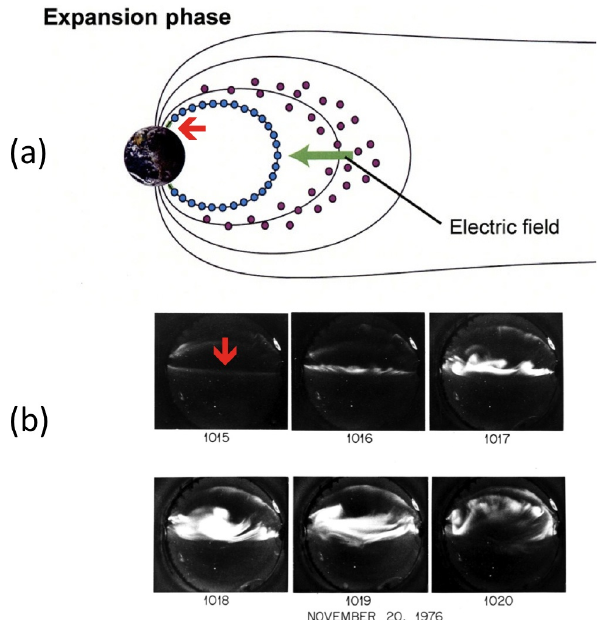
Figure 9. (a) A schematic representation of how the charge separa- tion and the eastward electric field might occur during the deflation (Akasofu, 2017). (b) An example of a series of all-sky photographs (Fairbanks, 65 ◦ gm lat), showing the initial brightening (shown by a red allow) and the subsequent poleward expansion.